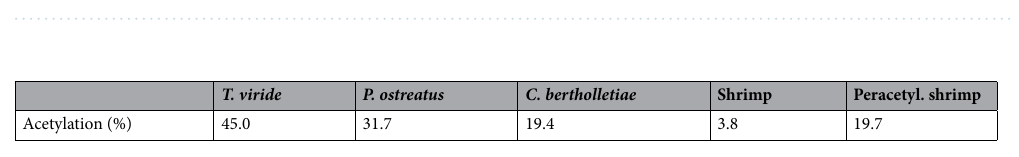
Table 2. Percent degree of acetylation of the extracted COs, as resulting from 1 H NMR spectra.